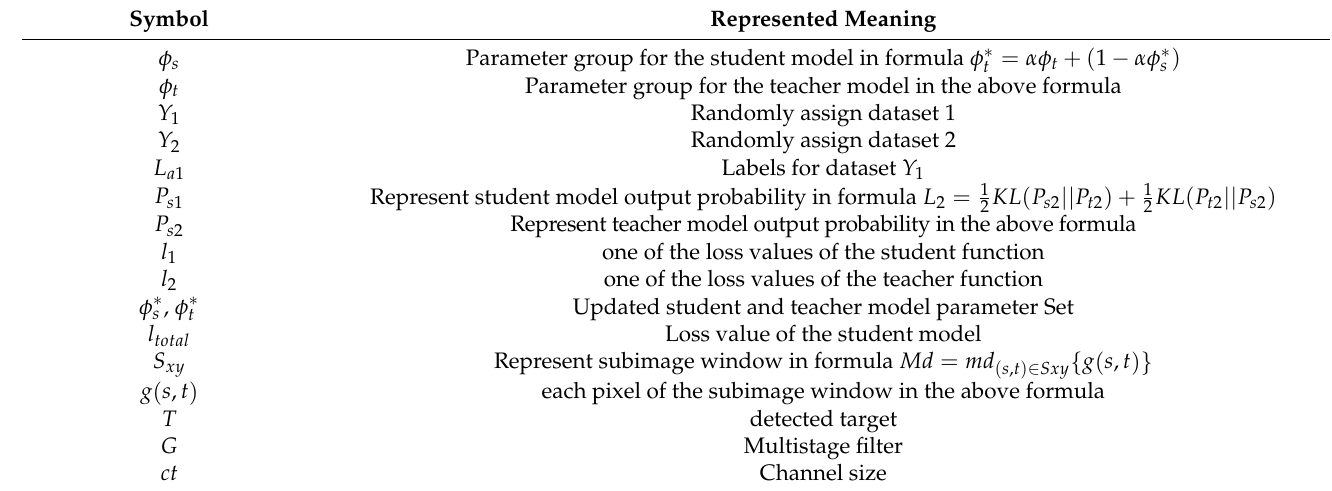
Figure 1. Overall architecture diagram of OSNDCN. Table 1. Symbol